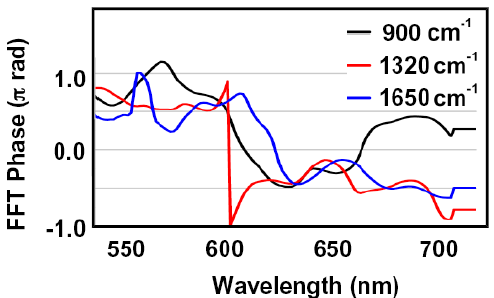
Figure 2. Fourier initial phase spectra of 900 cm − 1 (black line), 1320 cm − 1 (red line), and 1650 cm − 1 (blue line)